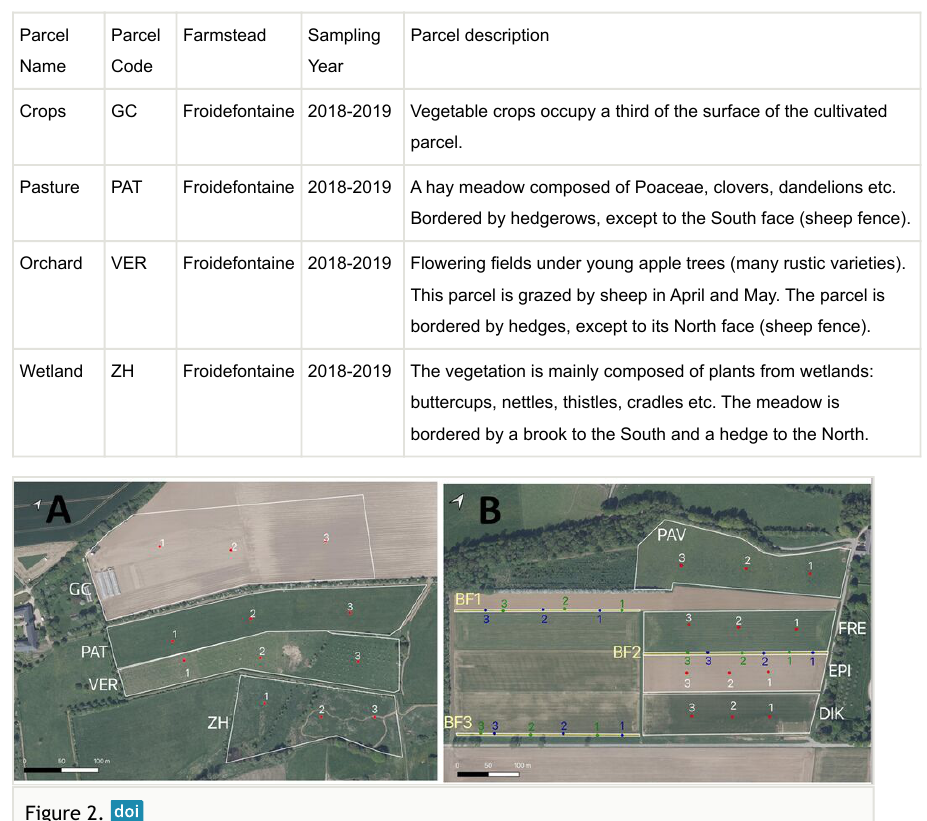
A. Froidefontaine farmstead map. GC, PAT, VER and ZH correspond to the sampled parcels, whose details are given in Table 1. Each numbered red dot corresponds to the position of a trio of coloured (white, yellow, blue) pantraps; B. Emeville farmstead map. PAV, FRE, EPI and DIK correspond to the sampled parcels, whose details are given in Table 1. Each numbered red dot corresponds to the position of a trio of coloured (white, yellow, blue) pantraps. BF1, BF2 and BF3 correspond to the sampled flower strips. Each blue or green numbered dot corresponds to the position of a trio of coloured (white, yellow, blue) pantraps for the "feeder" flower patch or the "pollinator" flower patch,